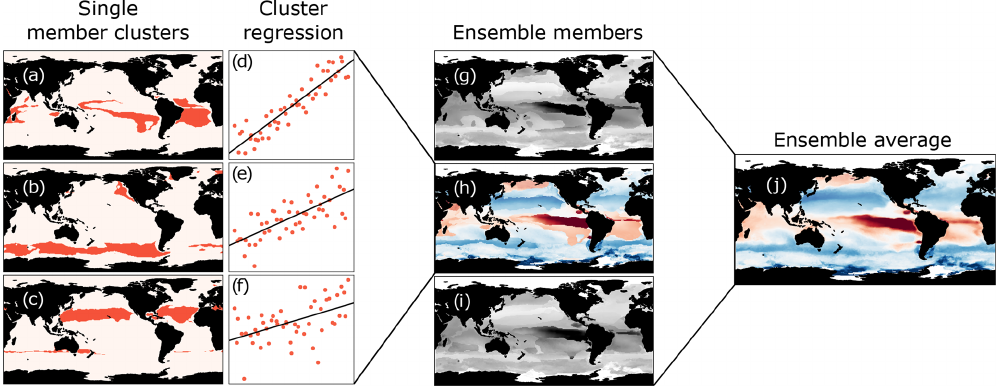
Figure 2. A schematic showing the steps used in the GRaCER method for a single month. Panels (a) – (c) show a subset of the clusters of a single ensemble member (h) , with the adjacent scatter plots (d) – (f) showing the training data for each cluster and the linear regression models for that cluster (with toy data). Panels (g) – (i) show the ensemble member estimates for a subset of three members for p CO 2 . Panel (j) shows the ensemble mean for all ensemble members, which includes ensemble members not shown in panels (g) – (i)